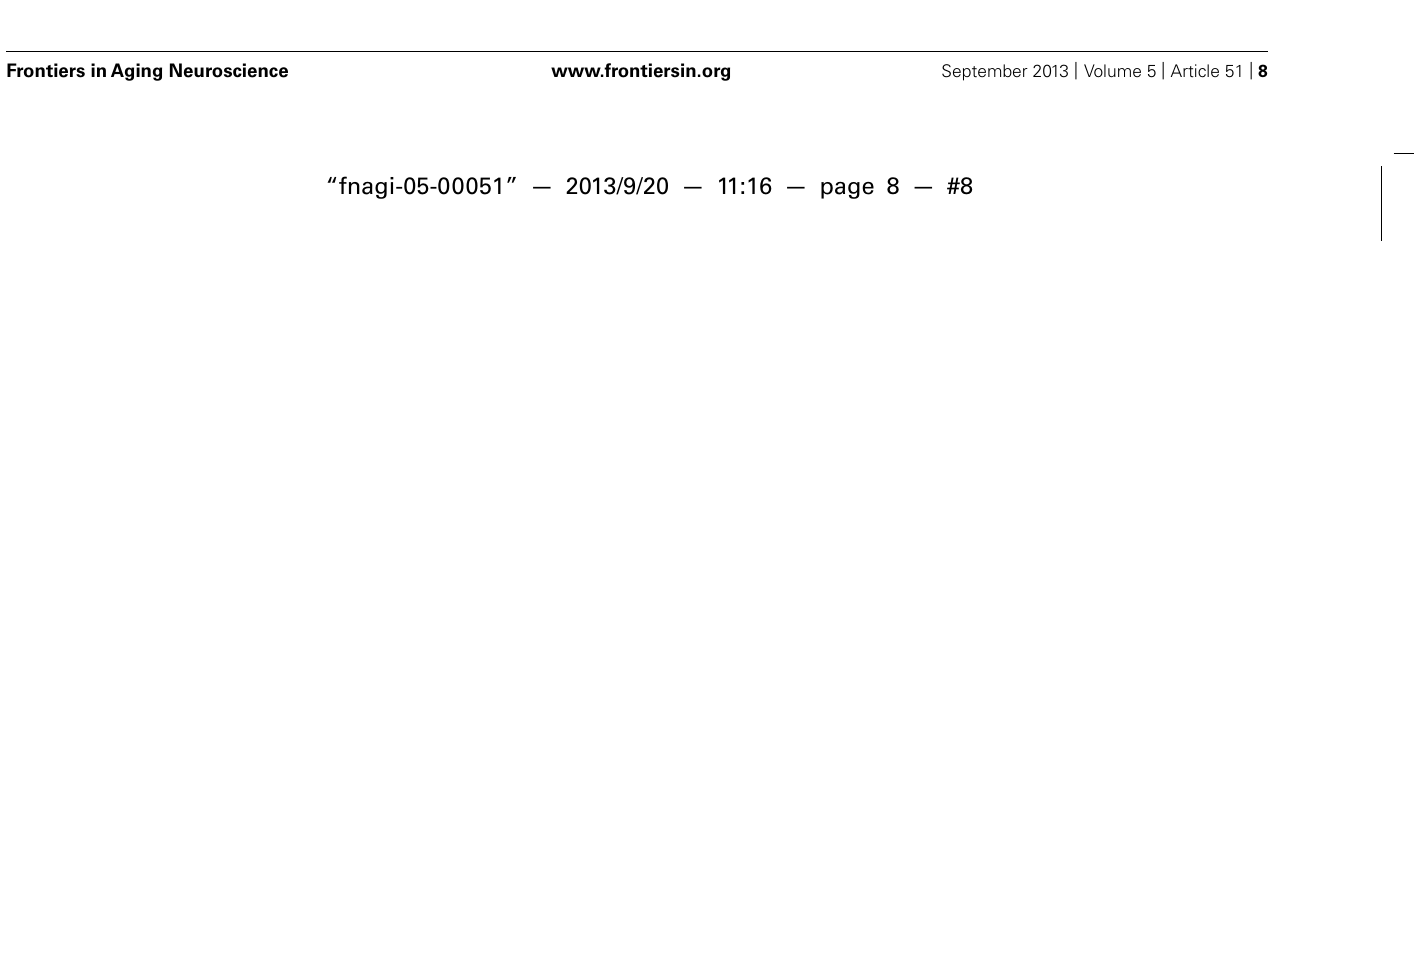
Middle temporal gyrus R BA 21 56 − 32 − 4 437 < 0.005 4.99 62 − 38 − 13 < 0.005 6.81 Fusiform gyrus R BA 37 51 − 44 − 9 < 0.005 Middle temporal gyrus R BA 21 49 3 − 30 85 < 0.005 4.53 Inferior temporal gyrus R BA 20 49 − 7 − 30 < 0.005 2.96 Perirhinal cortex L BA 36 − 34 − 29 − 17 59 < 0.005 3.84 Fusiform gyrus R BA 20 43 − 10 − 26 40 < 0.005 3.83 Lingual gyrus L BA 19 − 12 − 54 0 82 < 0.001 5.27 Posterior cingulate gyrus L BA 30 − 21 − 51 1 < 0.001 4.57 Insula R BA 13 39 2 1 109 < 0.001 5.15 Dorsolateral prefrontal gyrus L BA 46 − 45 40 9 64 < 0.001 4.88 − 42 32 7 < 0.001 4.85 Ventral anterior cingulate gyrus L BA 24 − 5 2 35 49 < 0.001 Insula L BA 13 − 38 7 − 3 43 <